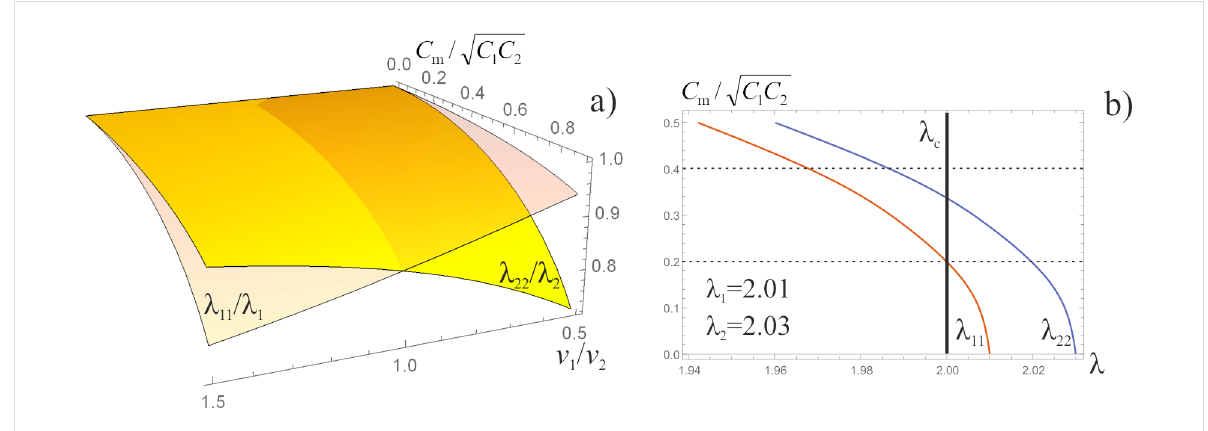
Figure 2: a) Critical surfaces corresponding to SIT at λ 11 = 2 and λ 22 = 2. b) Phase diagram for two capacitively coupled superconducting nanowires with λ 1 = 2.01 and λ 2 = 2.03. Both curves λ 11 ( C m ) and λ 22 ( C m ) decrease and cross the critical line λ c = 2 with increasing mutual capacitance, C m